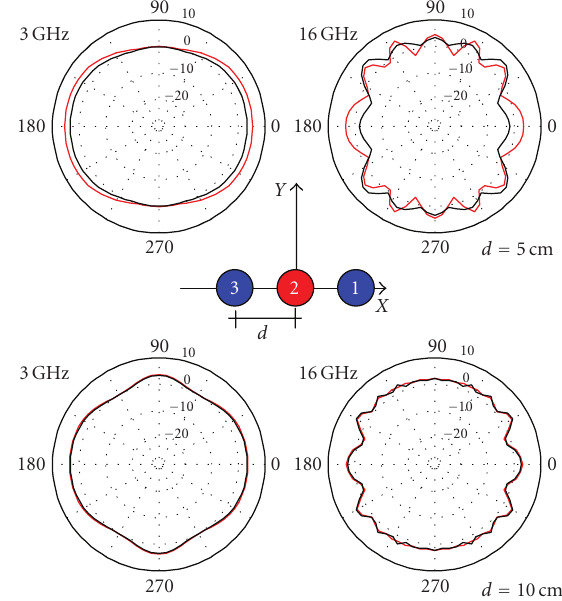
Figure 15: Three-bicone linear array with feeding on antenna 2 and open circuit on antennas 1 and 3. Expected azimuth (X-Y plane) radiation pattern (solid line) and SC approximation (red line).